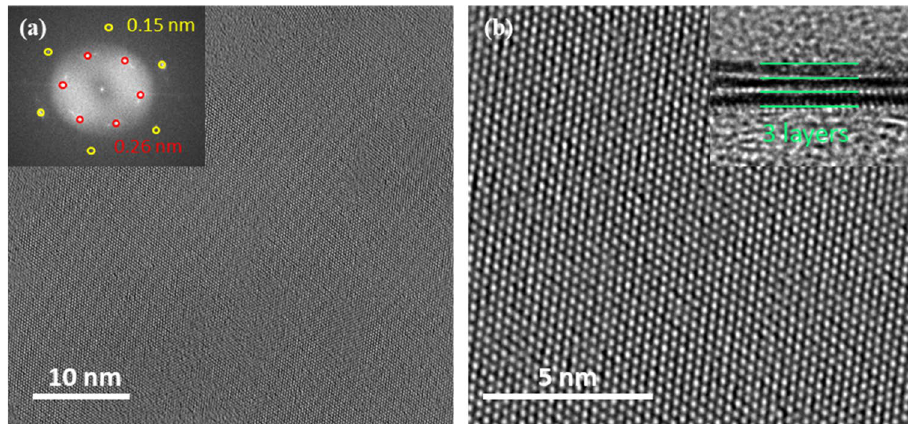
Figure 4. ( a ) Plan-view TEM image of printed MoS 2 prepared from 0.025 M on SiO 2 /Si. The inset is the FFT pattern. ( b ) High-resolution TEM image. The inset is a cross-section TEM image of 0.025 M solution-based MoS 2